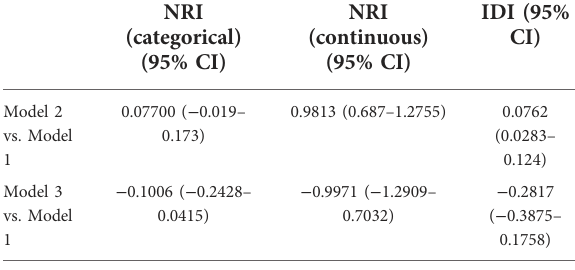
TABLE 8 NRI and IDI: Model 2 vs. Model 1, Model 3 vs. Model